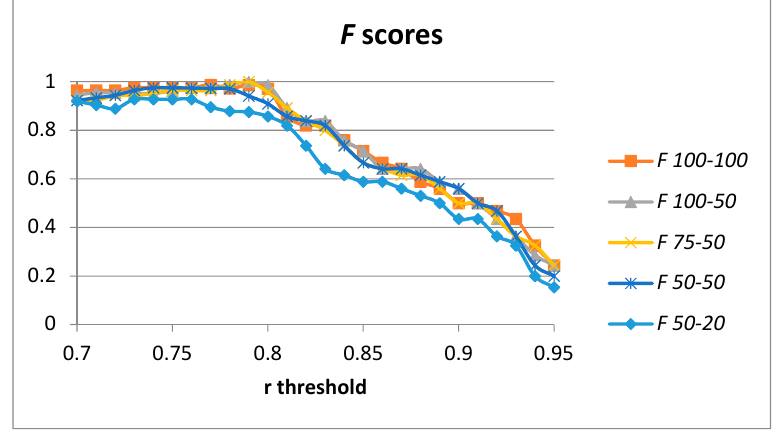
Figure 9. F scores for 2 stacked auto-encoders and 100-100, 100-50, 75-50, 50-50, and 50-20 hidden units.